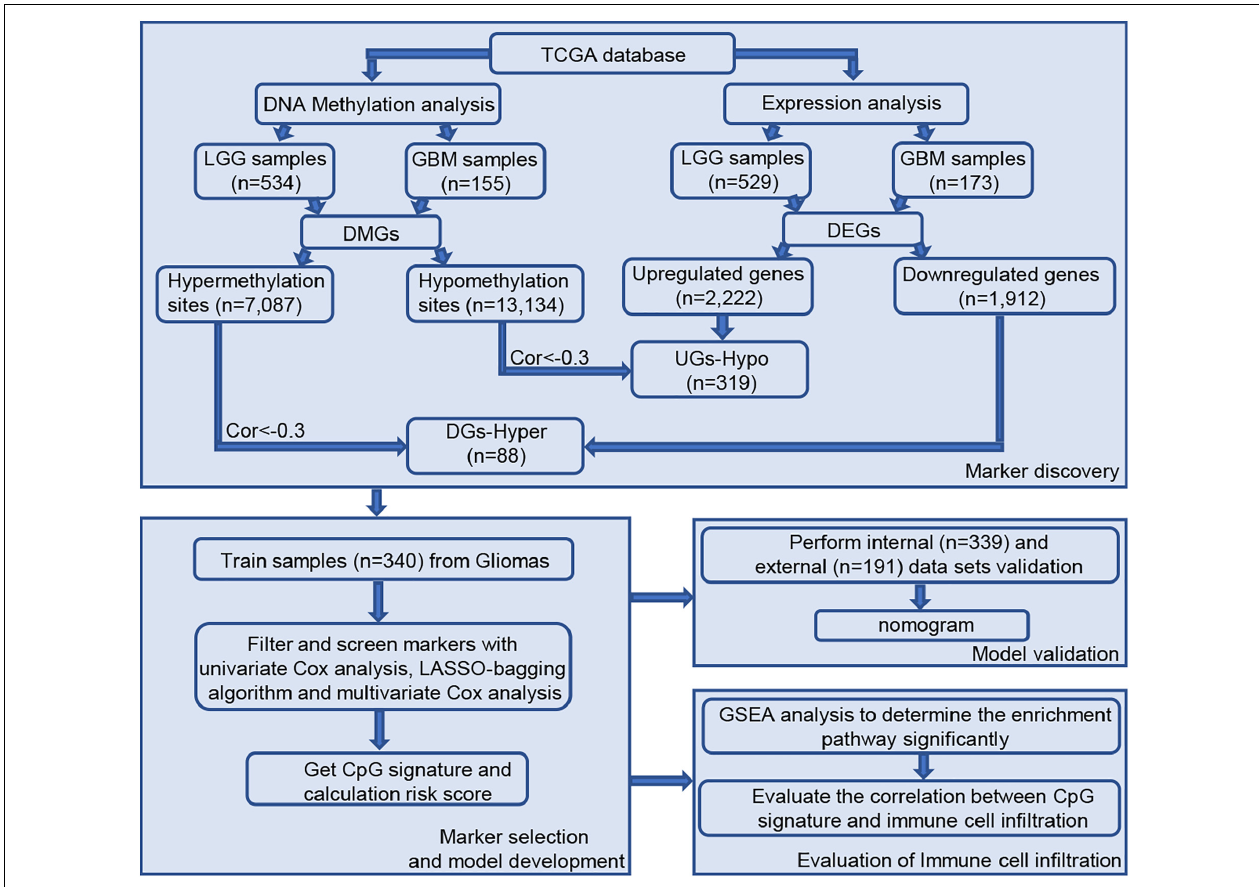
FIGURE 1 | Workflow of study design. Abbreviations: TCGA, The Cancer Genome Atlas; EI, epigenetically-induced genes; ES, epigenetically suppressed